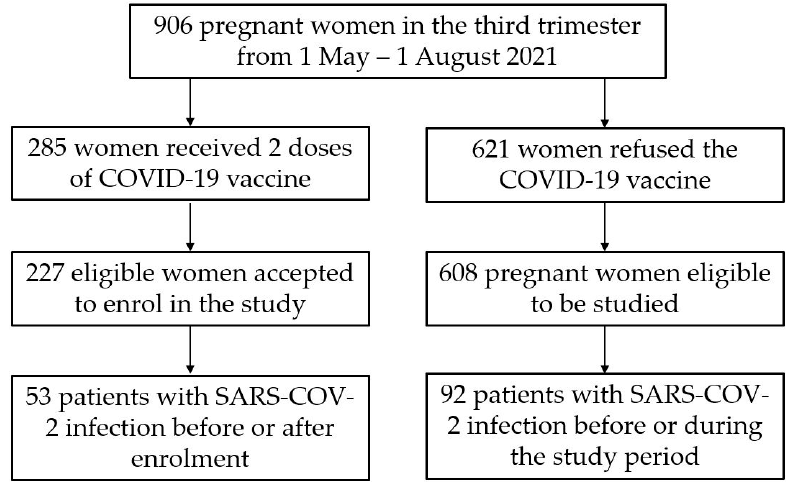
Figure 1. Flowchart of the study cohort. A total of 906 pregnant women were identified in their third trimester of pregnancy during the study period in the hospital database. Based on selection criteria, 285 women were eligible for inclusion in the vaccinated group after receiving two doses of COVID-19 vaccine, and the other 621 patients comprised the unvaccinated group. In total, 53 vaccinated pregnant women refused to consent for participation in the current study, leaving for a total of 227 eligible women in the vaccinated group. Moreover, 13 unvaccinated pregnant women refused to consent for participation, leaving for a total of 608 cases in the unvaccinated group. From the number of patients included in the study, those who suffered of SARS-CoV-2 infection (seropositive) before or after enrolment were separated from the main groups to stratify the data. A total of 53 vaccinated pregnant women and 92 unvaccinated pregnant women in their third trimester had a SARS-CoV-2